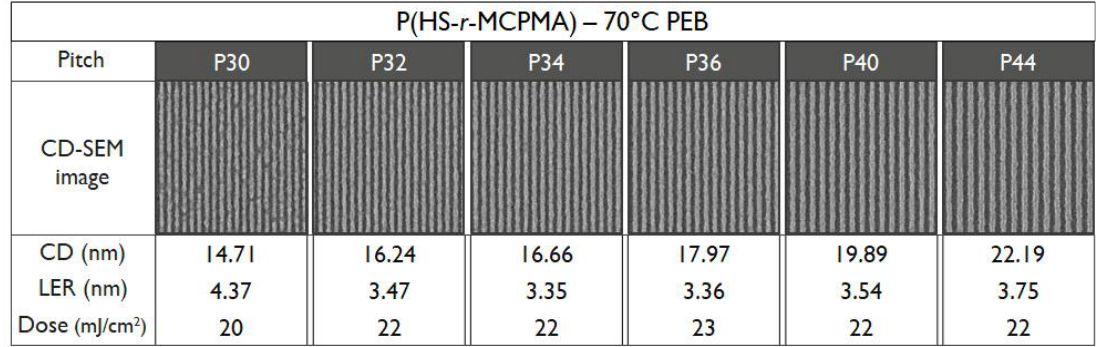
Figure 11. Patterning performance of the P(HS- r -MCPMA) polymer-based resist at 70 °C PEB.